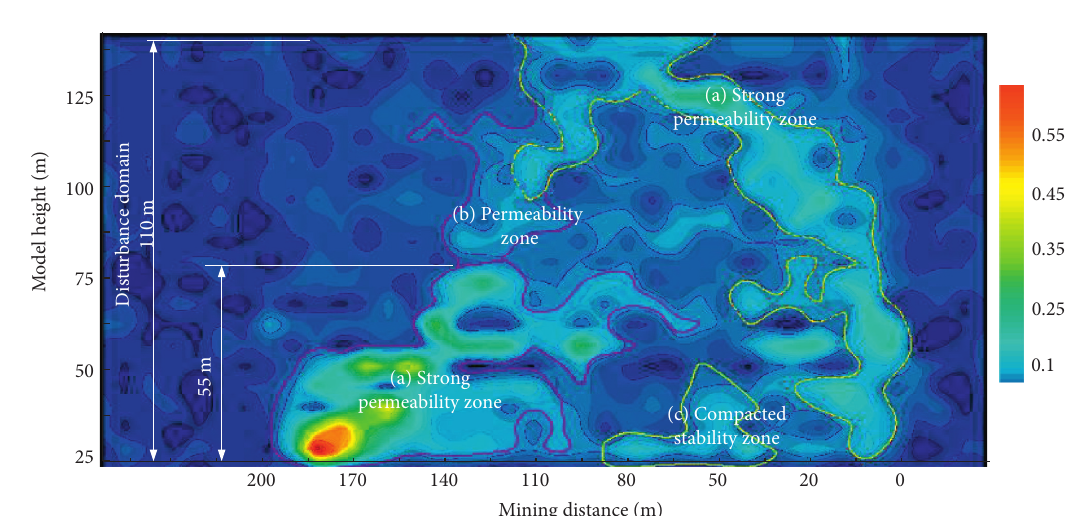
Figure 19: Permeability zoning in goaf when excavated to 190m of Scheme